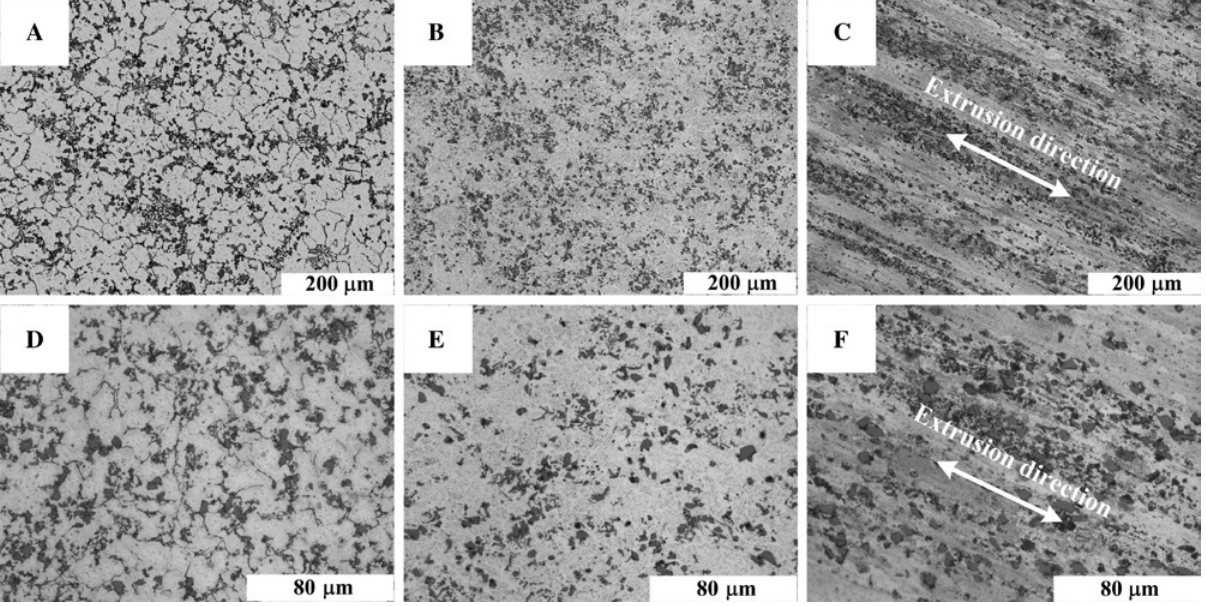
/Al2014 composites before and after extrusion: (A) as-cast composites, (B) cross-section, (C) longitudinal Figure 2: OM micrographs of SiC p section of extruded composites, and (D)–(F) images of (A)–(C) at high magnification,